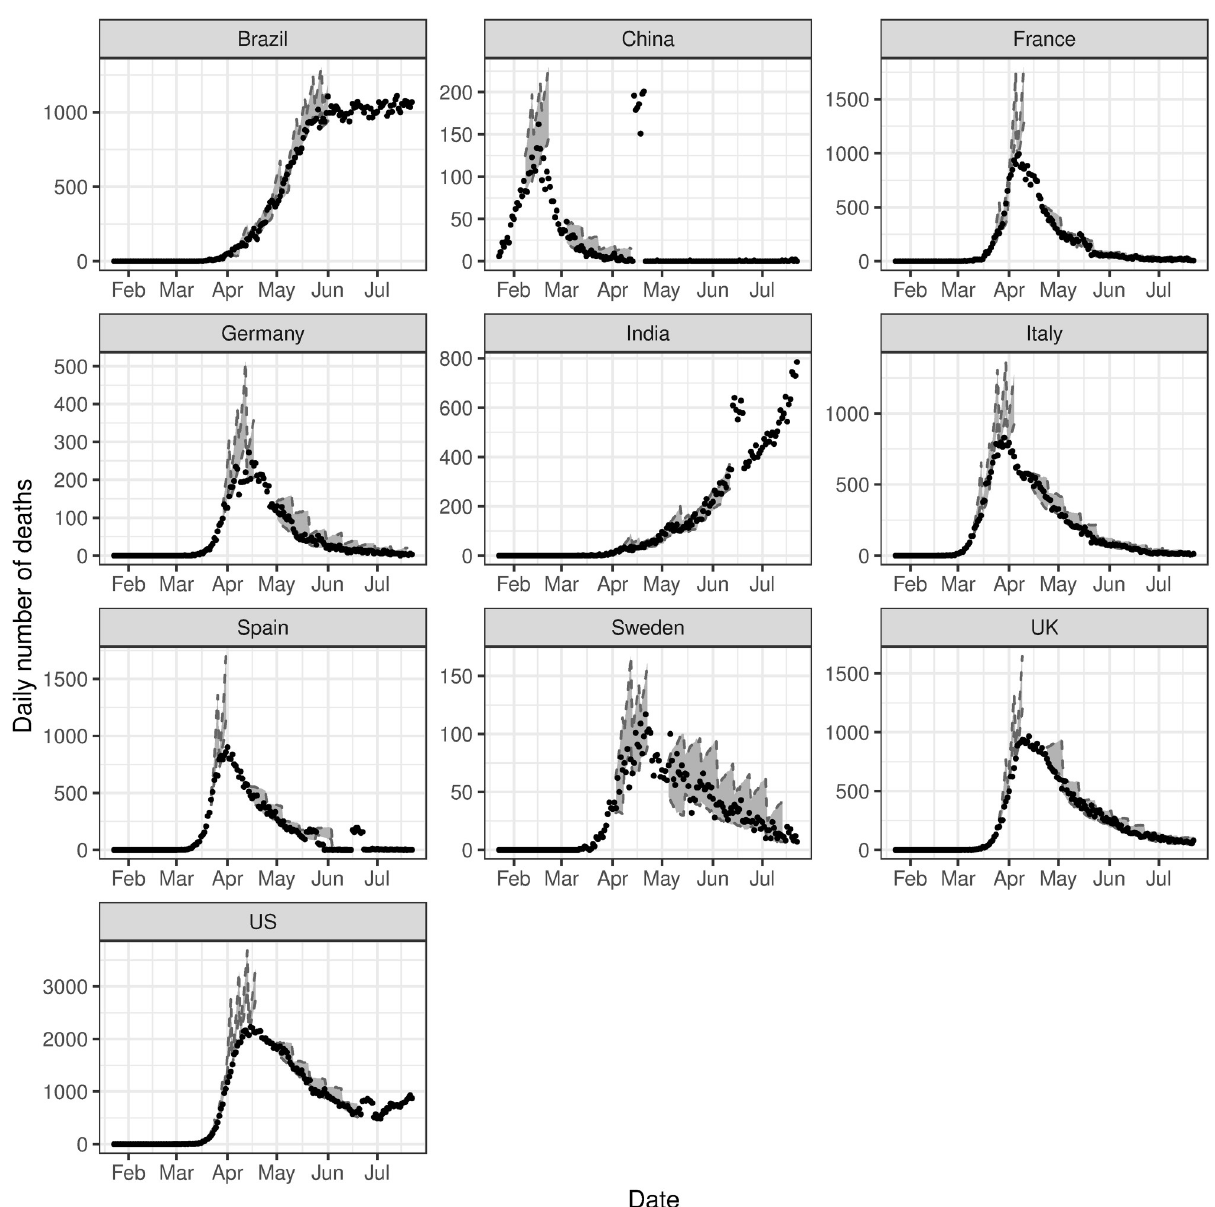
Fig 5. Out-of-sample validation. The observed number of deaths (black dots) compared to the 95% posterior predictive interval for the estimated expected number of events, i.e. λ ( t ) using various training datasets (grey ribbons).